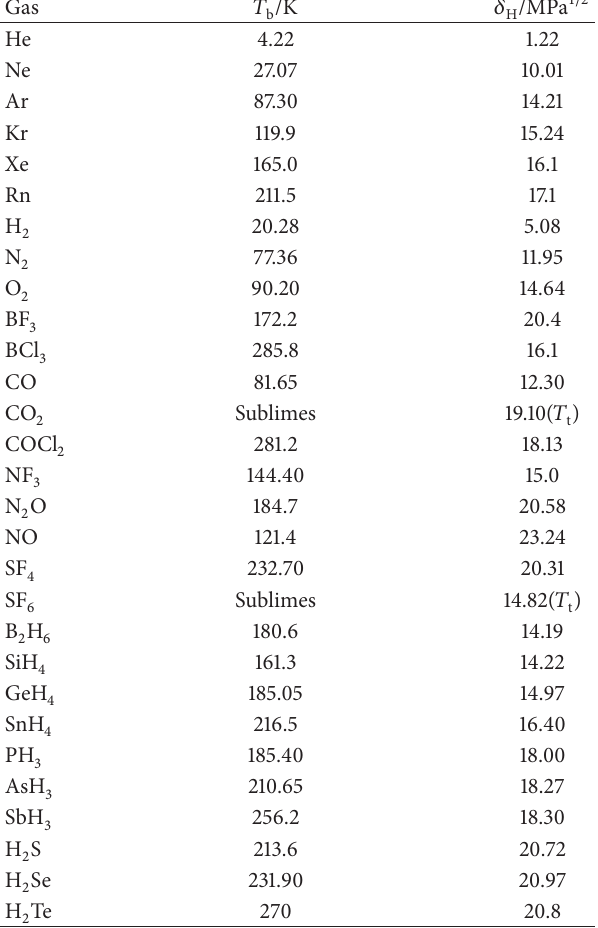
Table 1: Selected solubility parameters of liquefied inorganic gases at their boiling